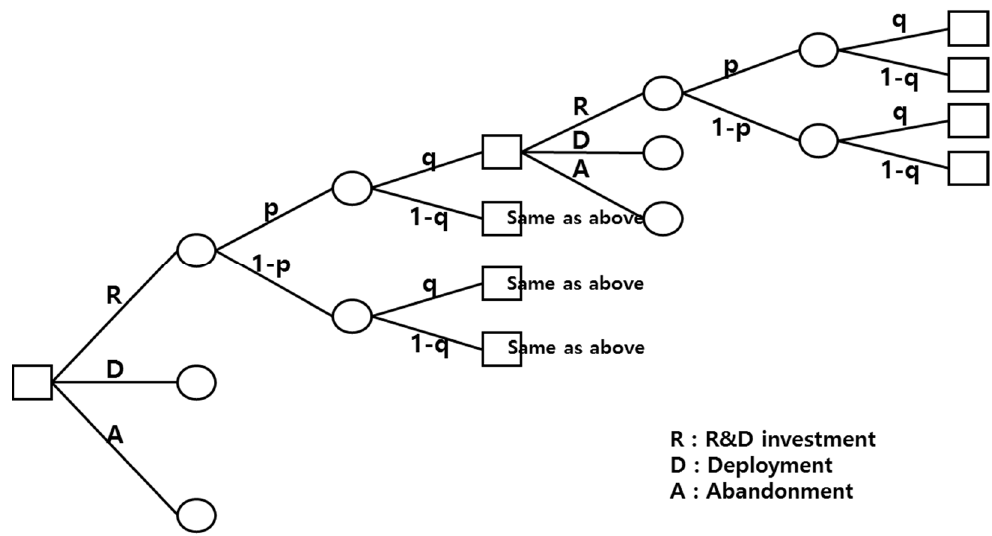
Figure 3. Decision Figure 3. Decision tree.